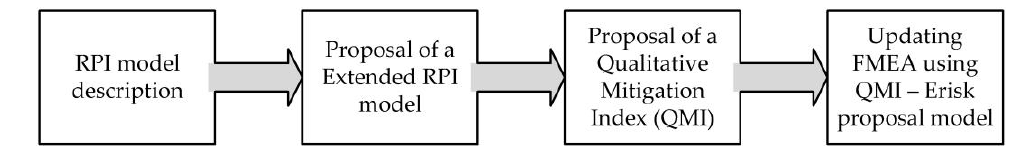
Figure 1. Materials and methods framework followed in this research.